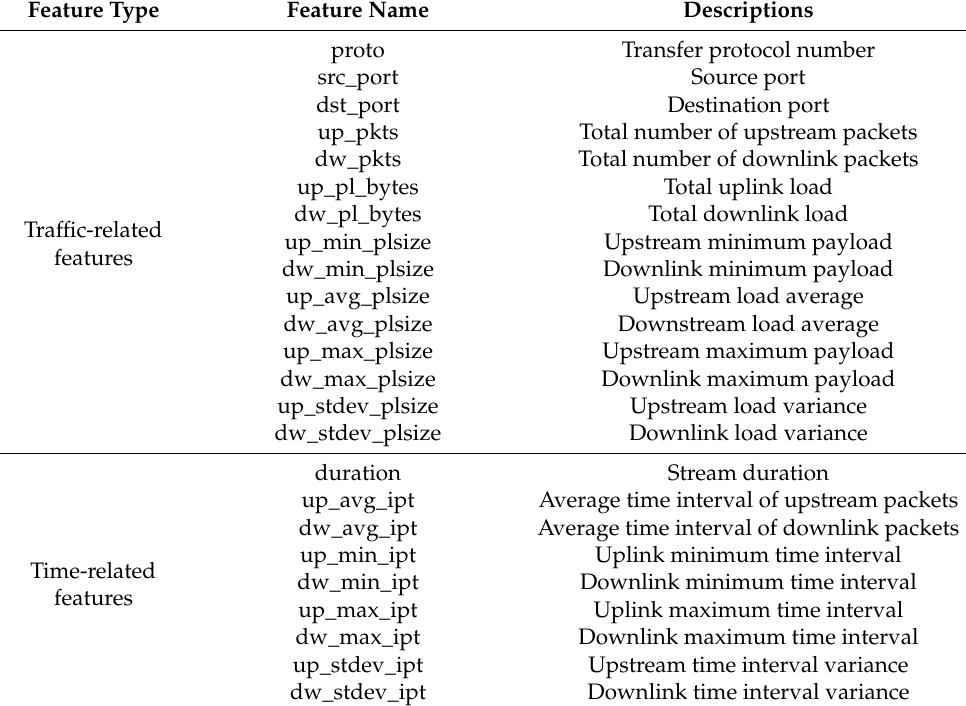
Table 2. Traffic features and